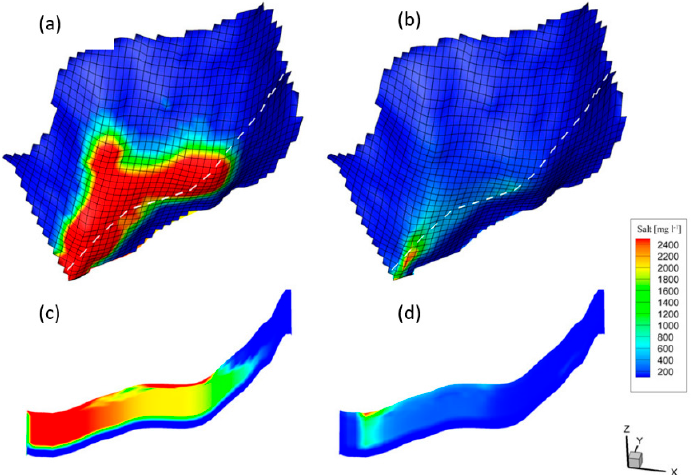
Figure 10. The 3D visualization of soil profile salinity simulations at the start (2011) ( a ) and the end (2107) ( b ) of the study period for the S3 configuration under RCP 4.5. ( c ) and ( d ) illustrate the soil profile salinity along the streams of the catchment (i.e., the white dashed line).